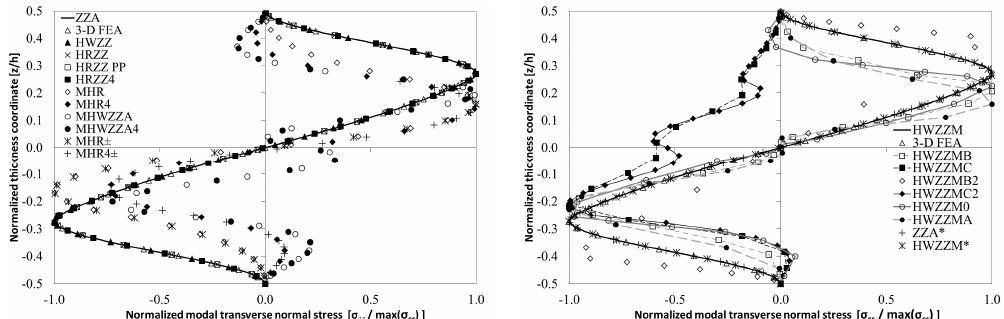
Figure 7. Case c1: Normalized modal displacements and stresses of a simply supported laminated plate ( L x/ h = 5, E 1 /E 2 = 40).